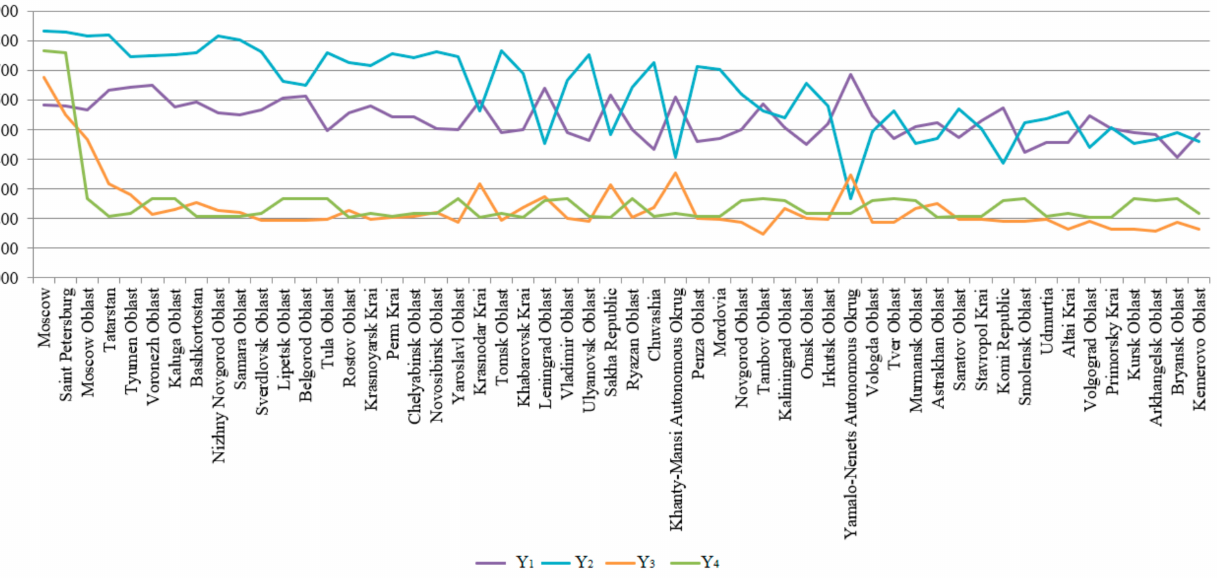
Figure 5. Russian regions according to the aggregate indicators of groups Y 1 , Y 2 , Y 3 , and Y 4